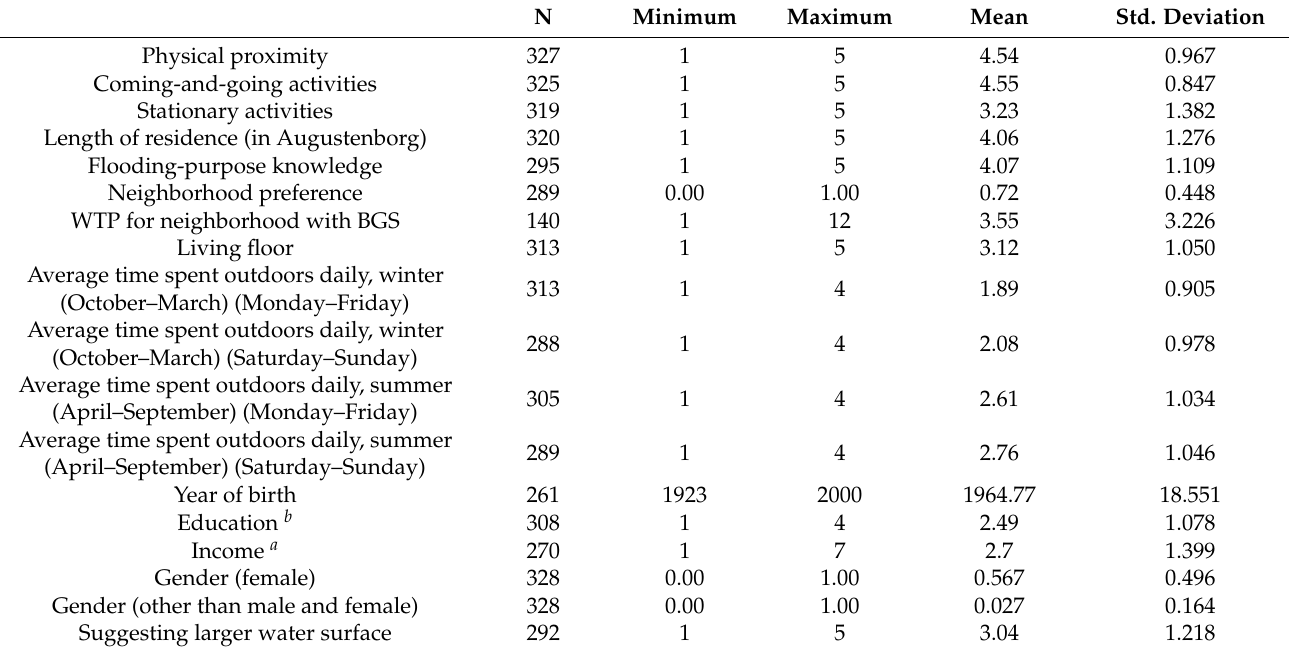
Table 2. Descriptive statistics of the studied sample.